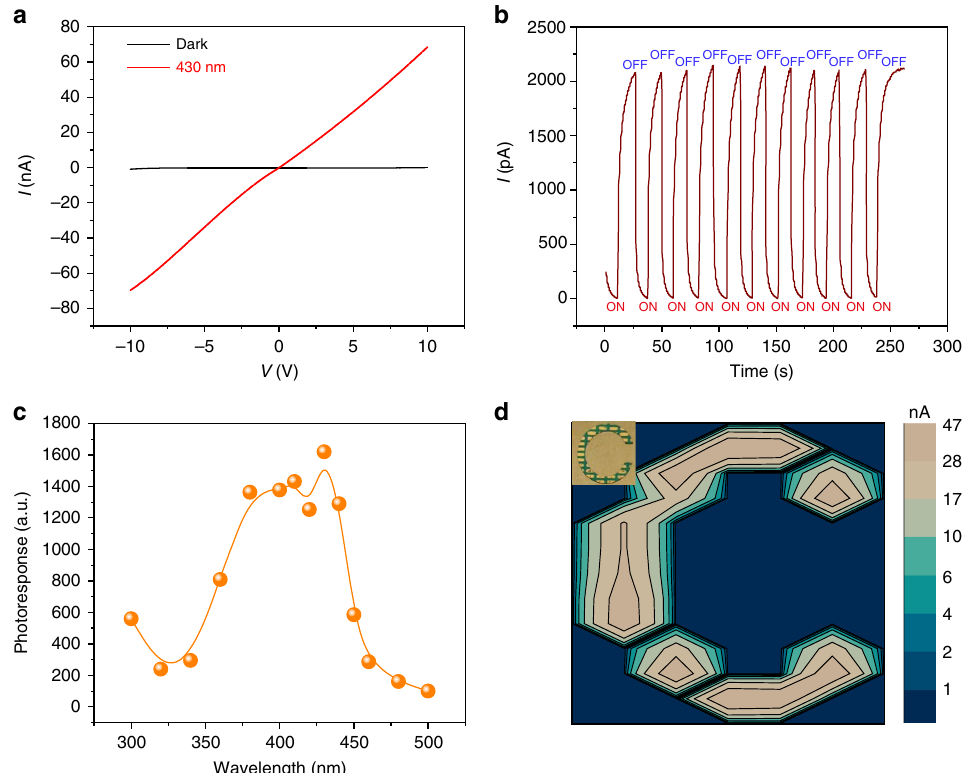
Fig. 4 Performance of the two-terminal DPA-based photodetector. a The typical I – V curve of the two-terminal device in dark and under illumination at 430 nm (0.4 mW cm − 2 ). b Photo-response measurements of the device in dark and under illumination (bias voltage, 10 V). c I illumination / I dark as a function of time under illumination. d Current mapping of the 6 × 11 imaging matrix under illumination with “ C ” type mask (1.5 cm × 1.5 cm) on